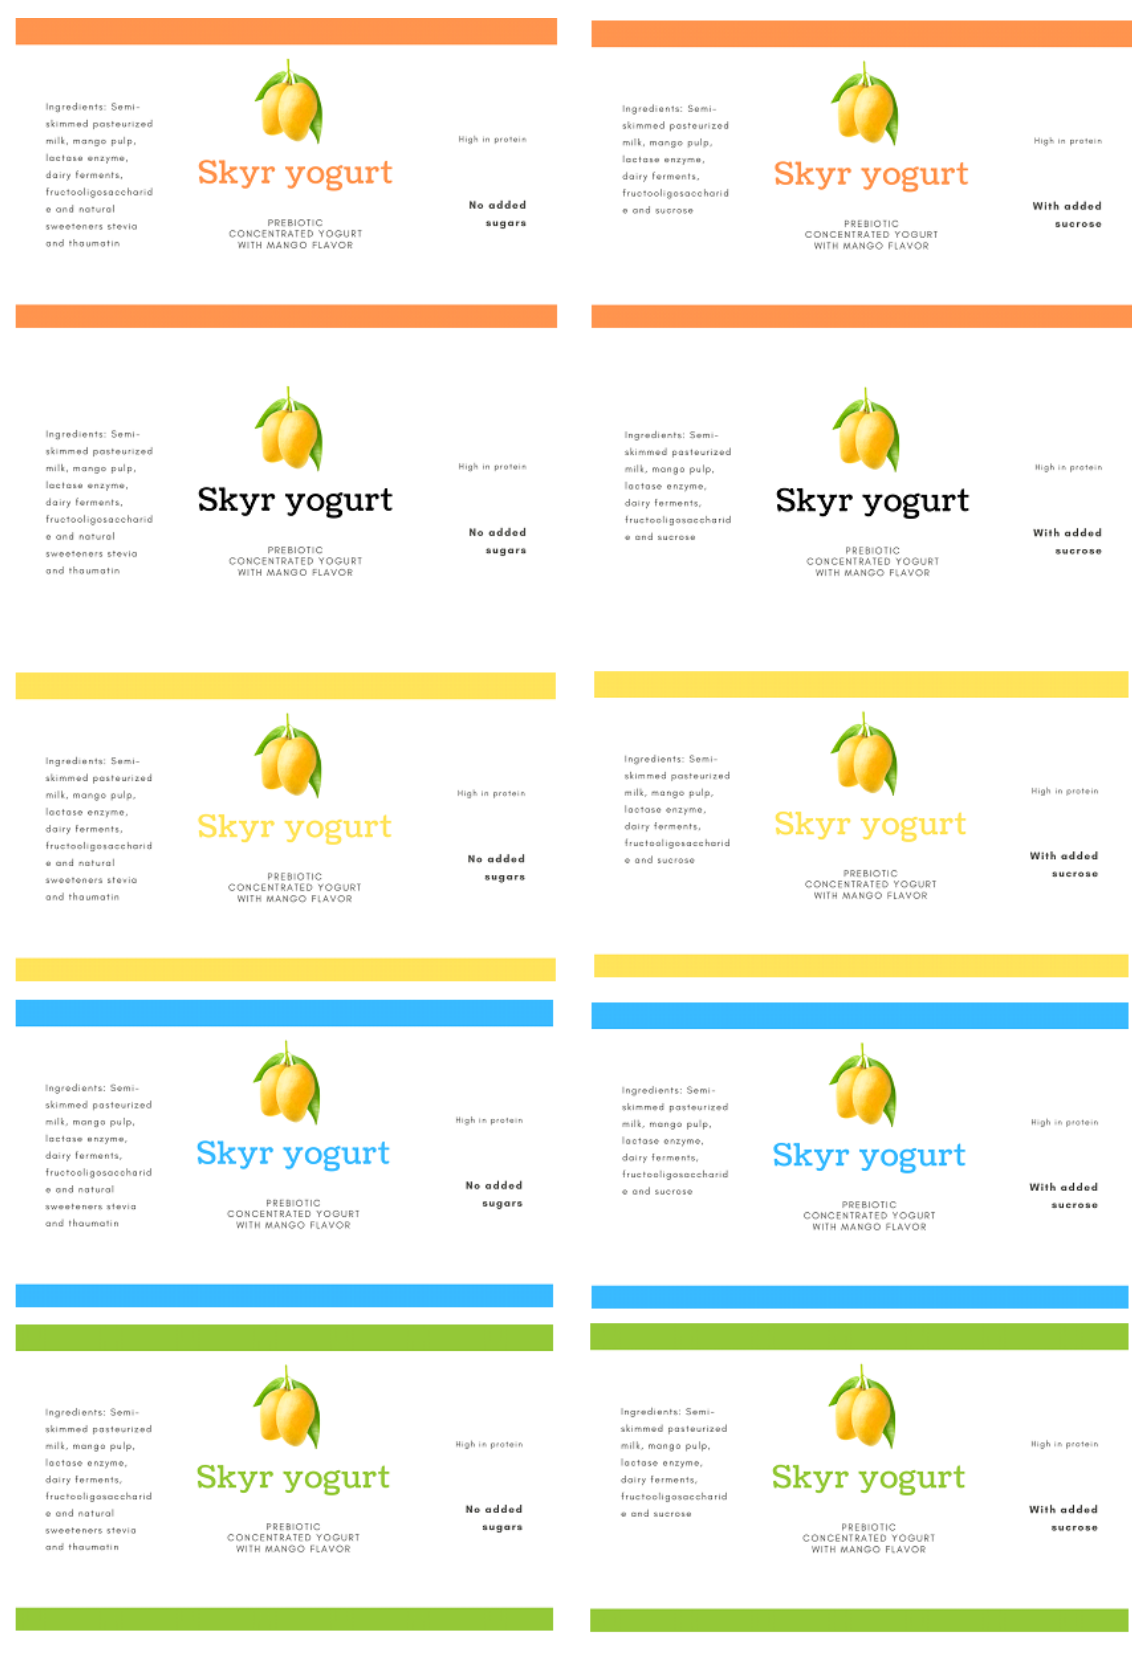
Figure 1. Representation of ten labels used in the study (L1 to L10).